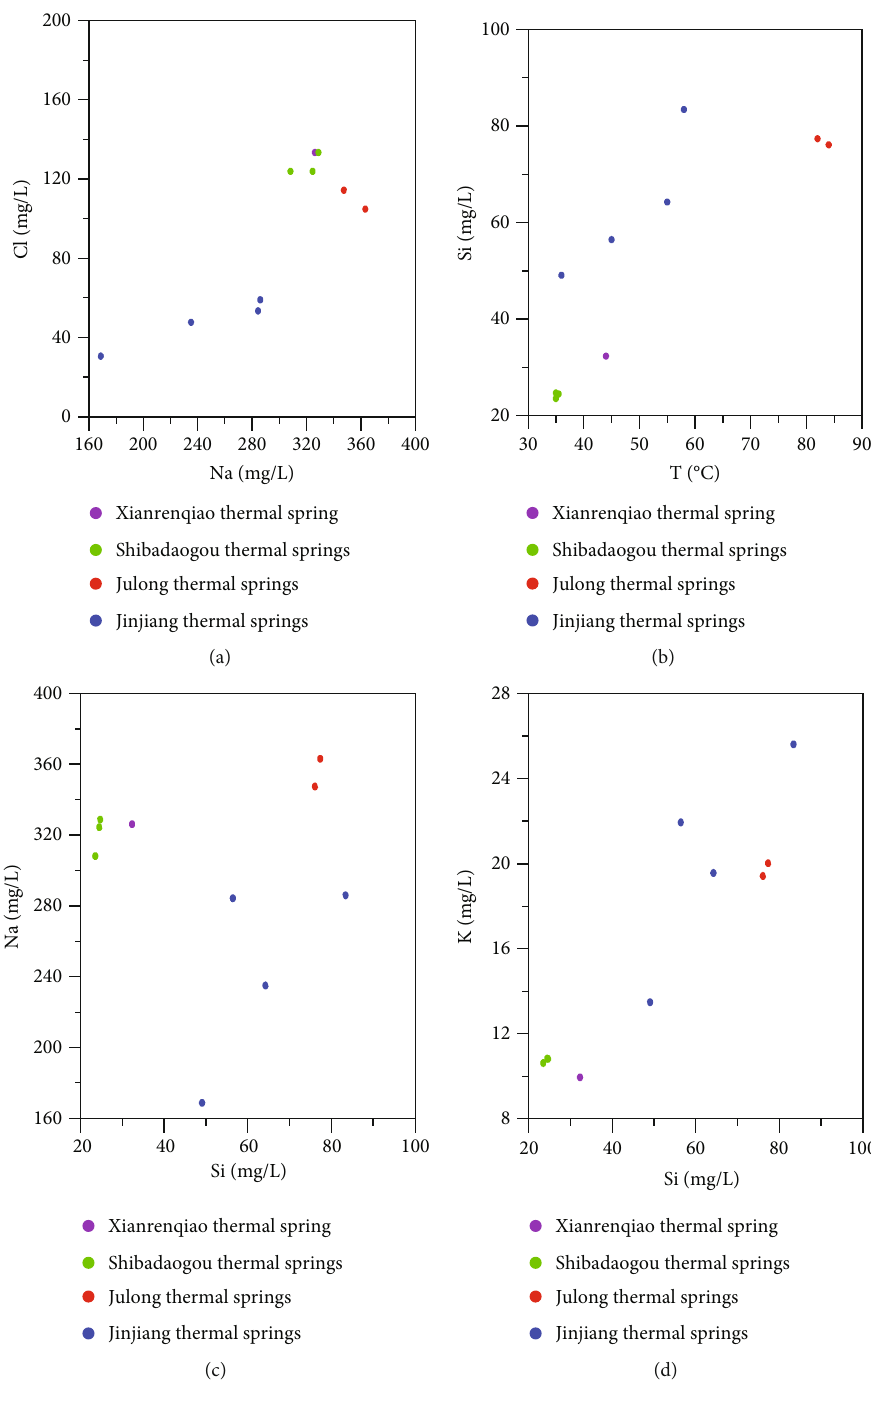
Figure 3: (a) Na vs. Cl concentration plot for thermal spring samples. (b) Si-temperature relationships for thermal spring samples. (c) Na vs. Si concentration plot for thermal spring samples. (d) K vs. Si concentration plot for thermal spring